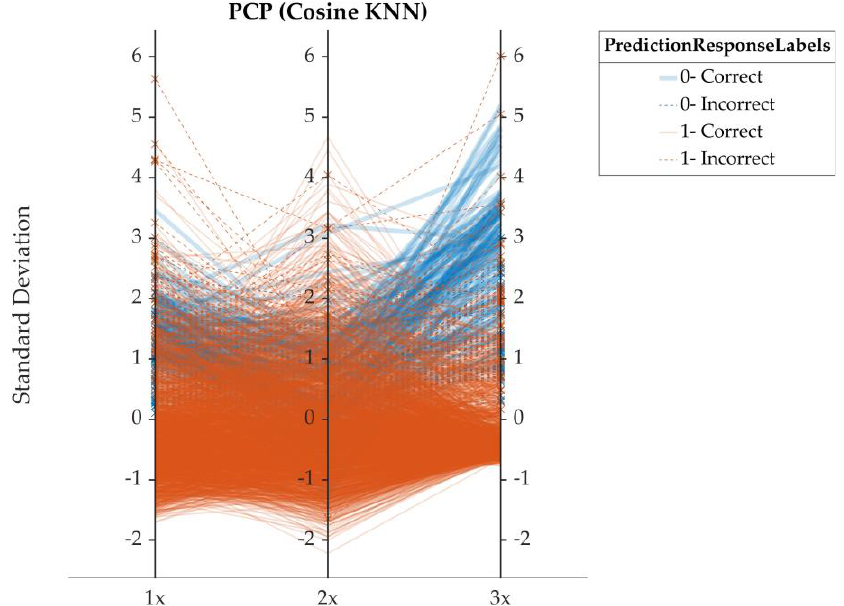
Figure 6. PCP sym9 and KNN-cosine.